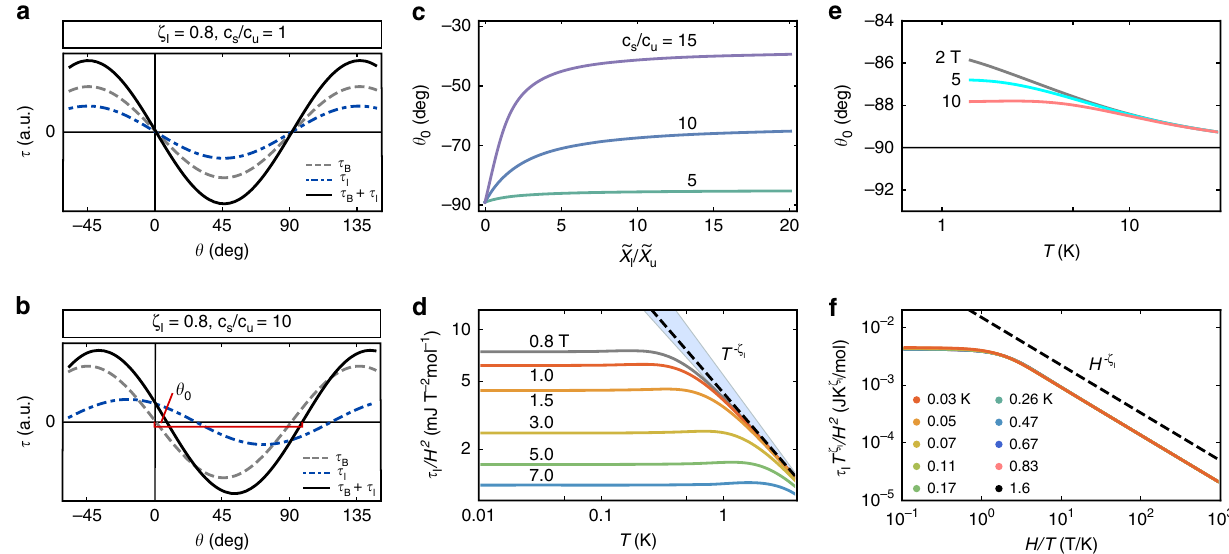
fi elds (compare with ref. 17 , Fig. 2c). f Plot of